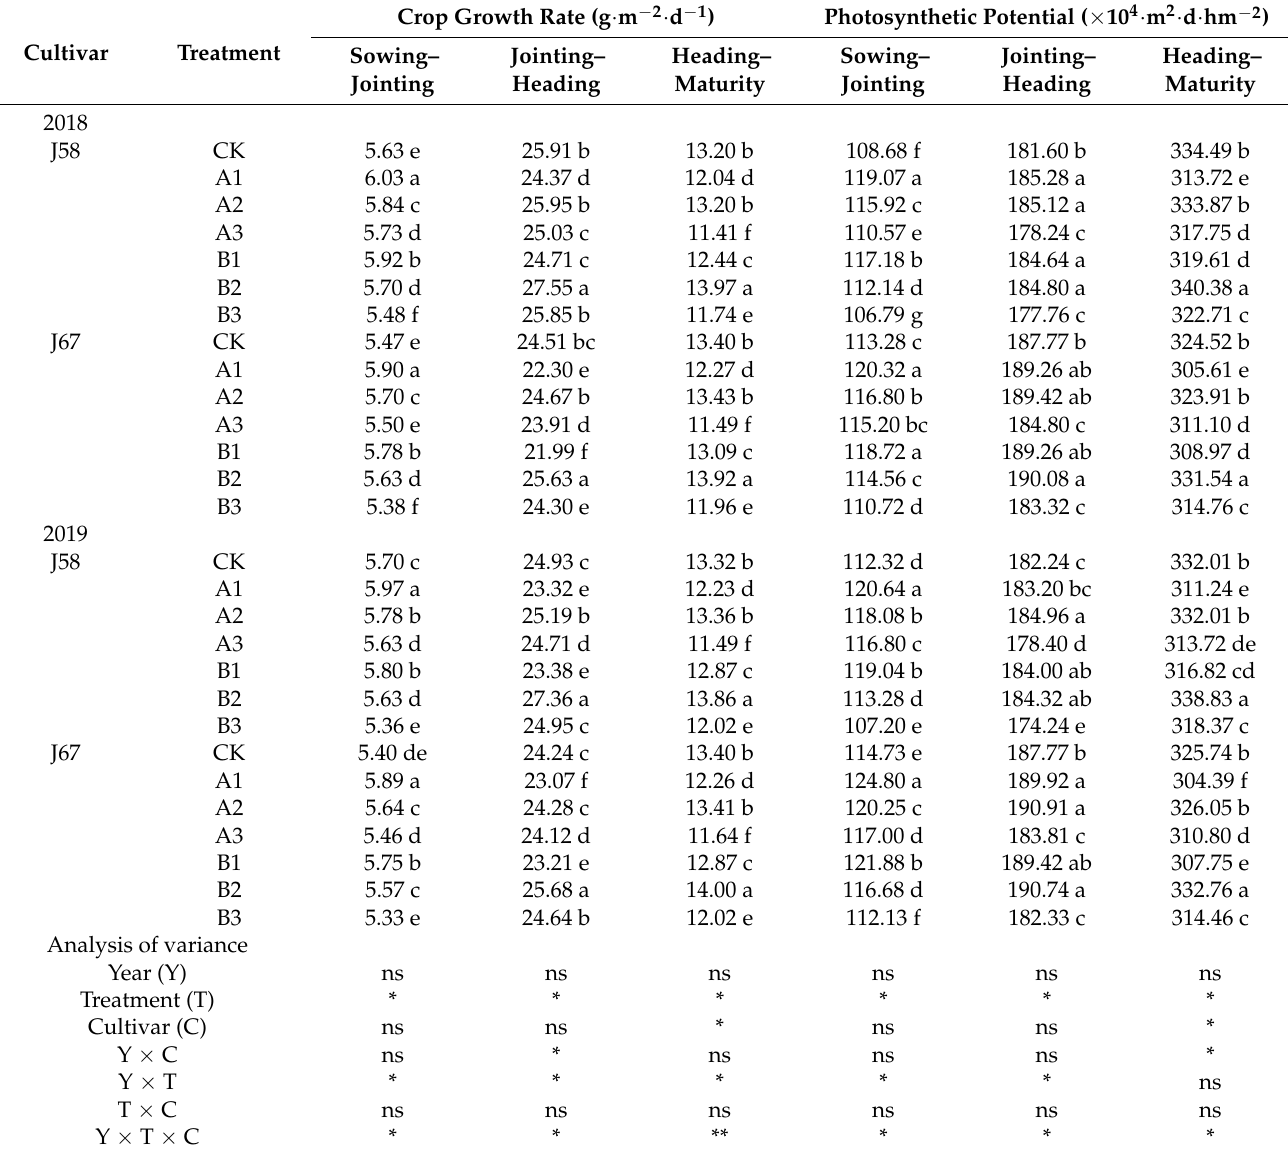
Table 5. Differences in photosynthetic potential and crop growth rate of japonica rice.